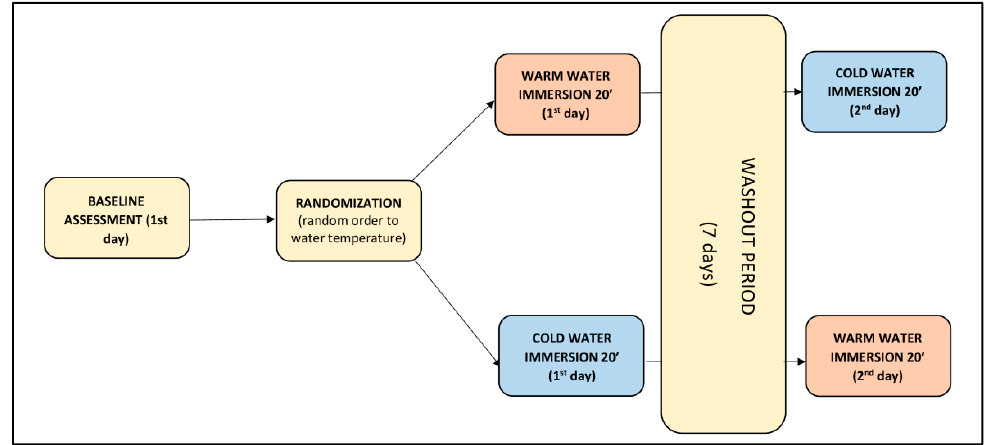
Figure 1. Measurement protocol on two non-consecutive days (washout period 7 days).